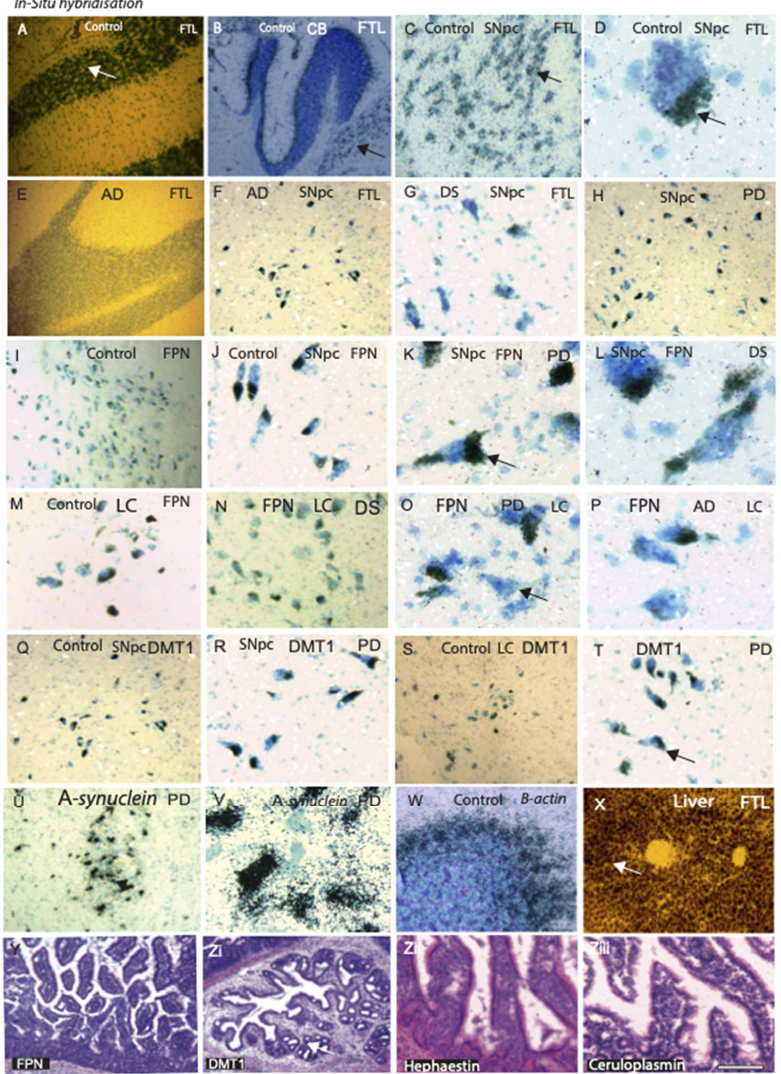
Figure 2. FTL, FPN, and DMT1 mRNA expression in AD, PD, and DS brain tissues. The mRNA expression of FTL, FPN, and DMT1 were detected by in situ hybridisation of AD, DS, PD, and age-matched control brain tissues. In control brain sections, ferritin (FTL) mRNA was visible in hippocampus (HP) and dentate gyrus granule cells ( A ) and cerebellum ( B ). In the SNpc, NM cells showed strong hybridisation signal of FTL ( C , D ), indicated by arrow) and minimal signals in the HP of AD subjects ( E ). FTL mRNA was visible in the PD and AD SNpc ( F , H ), whereas the DS brain (SNpc) showed very low levels of FTL mRNA expression, and most of the NM cells were empty ( G ). The ferroportin (FPN) was visible in the NM cell membrane of control brain sections ( I ); higher magnification ( L ), whereas it was limited in PD ( K ) and DS ( L ) brains and was only detected in the axon initial segment (AIS) of the NM cells ( J – L ). There was less ferroportin mRNA expression in LC when compared to SNpc in control ( M ), DS ( N ), PD ( O ), and AD ( P ) brain. DMT1 mRNA was detected in the AIS of the NM cells in SNpc in control ( Q ), in PD ( R ), and in LC of control ( S ) and PD brain, indicated by arrow ( T ). Two PD brain samples were hybridised with α -synuclein probes, which was highly expressed in the SNpc of PD brain ( U , V ). A β -actin probe was showing strong expression in the cerebellum ( W ). A mouse liver section was probed with FTL showing strong signal ( X ). Ferroportin and DMT1 mRNA was expressed mainly in the gut endothelium, and when mouse gut sections were probed with ferroportin ( Y ), DMT1, hephaestin, and ceruloplasmin ( Zi – Ziii ), results showed mRNA expression in the gut mucosa. Scale bar: ( A – C , E – J , M – Q , W , X ) = 100 µ m; ( D , J – L , O , P , V ) = 25 µ m; ( Y , Zi – Ziii ) = 20 µ